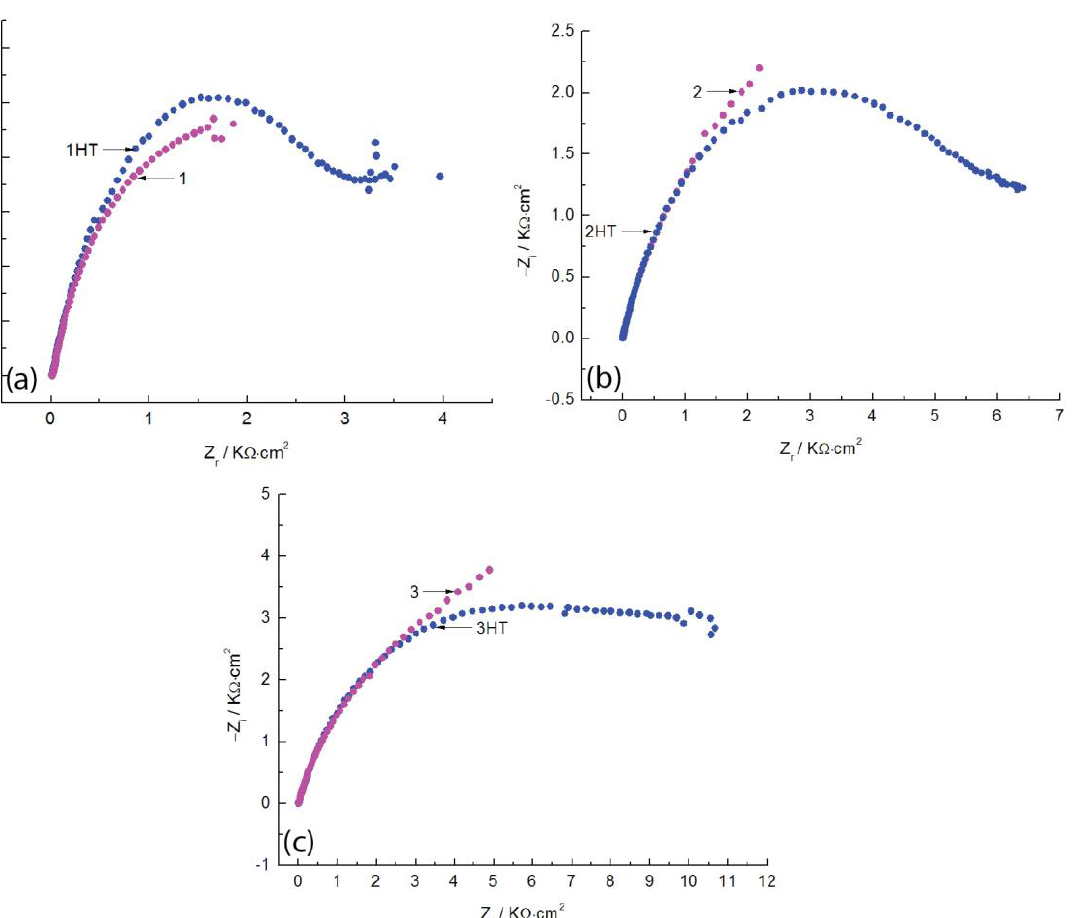
Figure 6. The equivalent electrical circuit model used to fit the experimental data: ( a ) for uncoated Cu and ( b ) Cu/HEA thin films in artificial seawater. In this case, the phase element constant CPE is introduced in the circuit instead of a regular double-layer capacitor (C dl ) in order to provide a more accurate match: C dl = Y 0 (ω max ) n − 1 ; CPE is used to describe the deformation of the capacitive semicircle correspond- ing to the heterogeneity of the electrode surface due to its roughness and the presence of impurities. The CPE impedance can be defined as: Z CPE = Y 0 −1 (jω) – n , where ω is the angular fre- quency (ω = 2πf), j is an imaginary number (j 2 = − 1), Y 0 is the amplitude compared to a capacitance and n is the phase change. The value of n provides details about the degree of in homogeneity of the metal surface. A higher value for n is associated with a lower sur- face roughness (reduced in homogeneity).